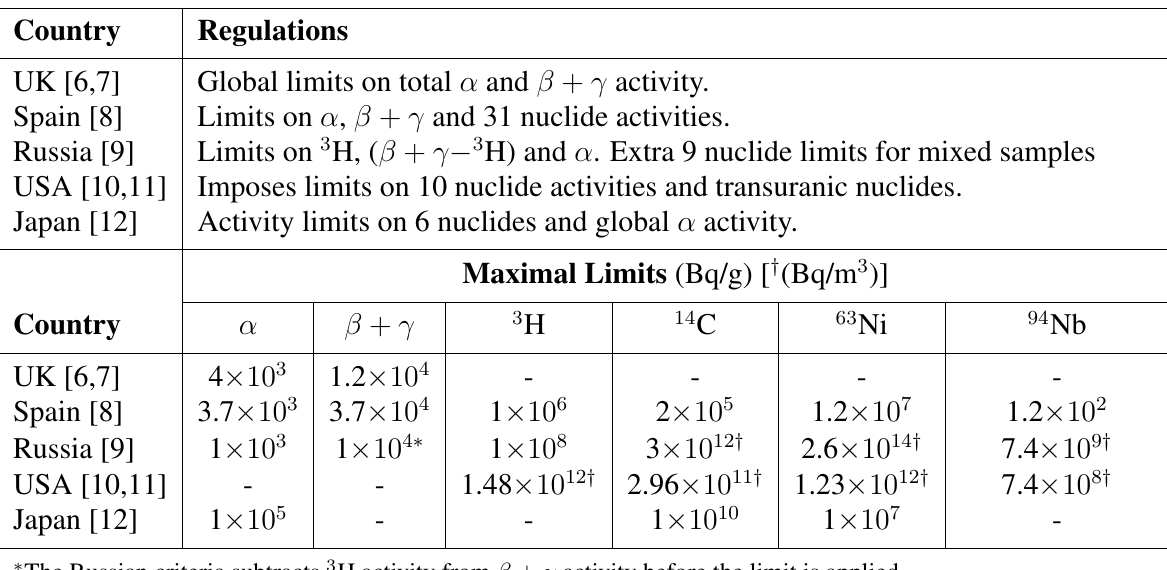
Table 1: The regulations and a selection of limits of waste relevant nuclides for the waste classification systems used in this